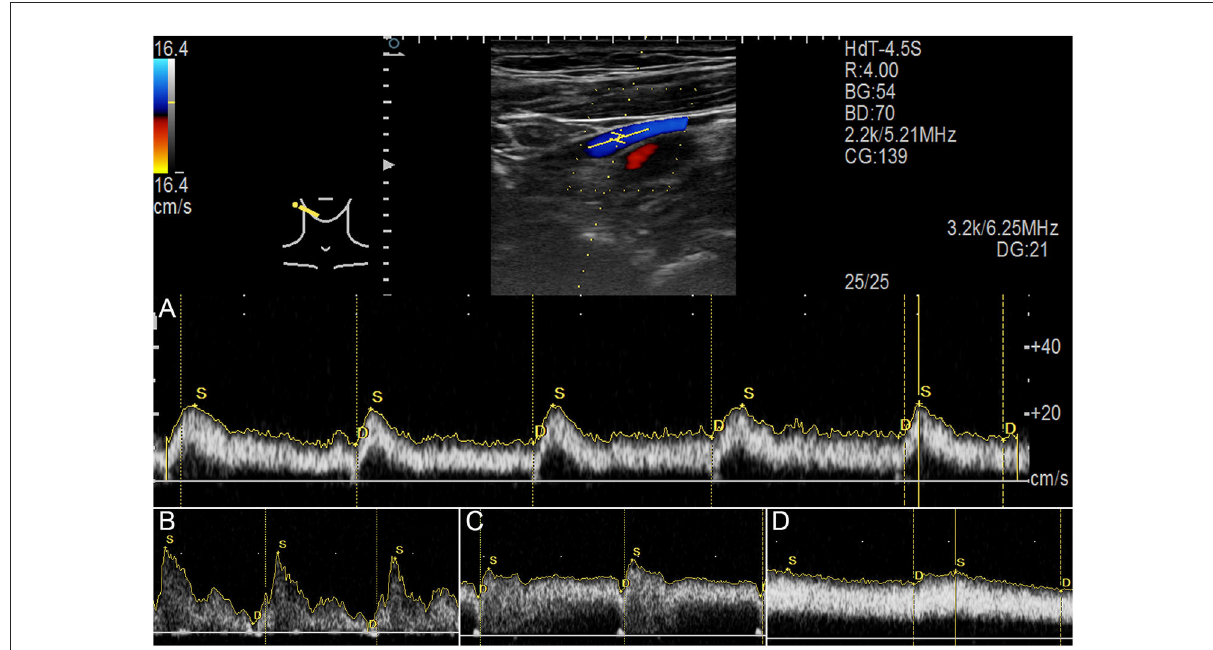
FIGURE3 Jugular Doppler ultrasound velocity spectra. (A) Ultrasound measurement of upper internal jugular vein (IJV). (B) Flow spectrum demonstrating an averaged pulsatility index (PI) of 1.54. (C) Flow spectrum demonstrating an averaged PI of 0.46. (D) Flow spectrum demonstrating an averaged PI of